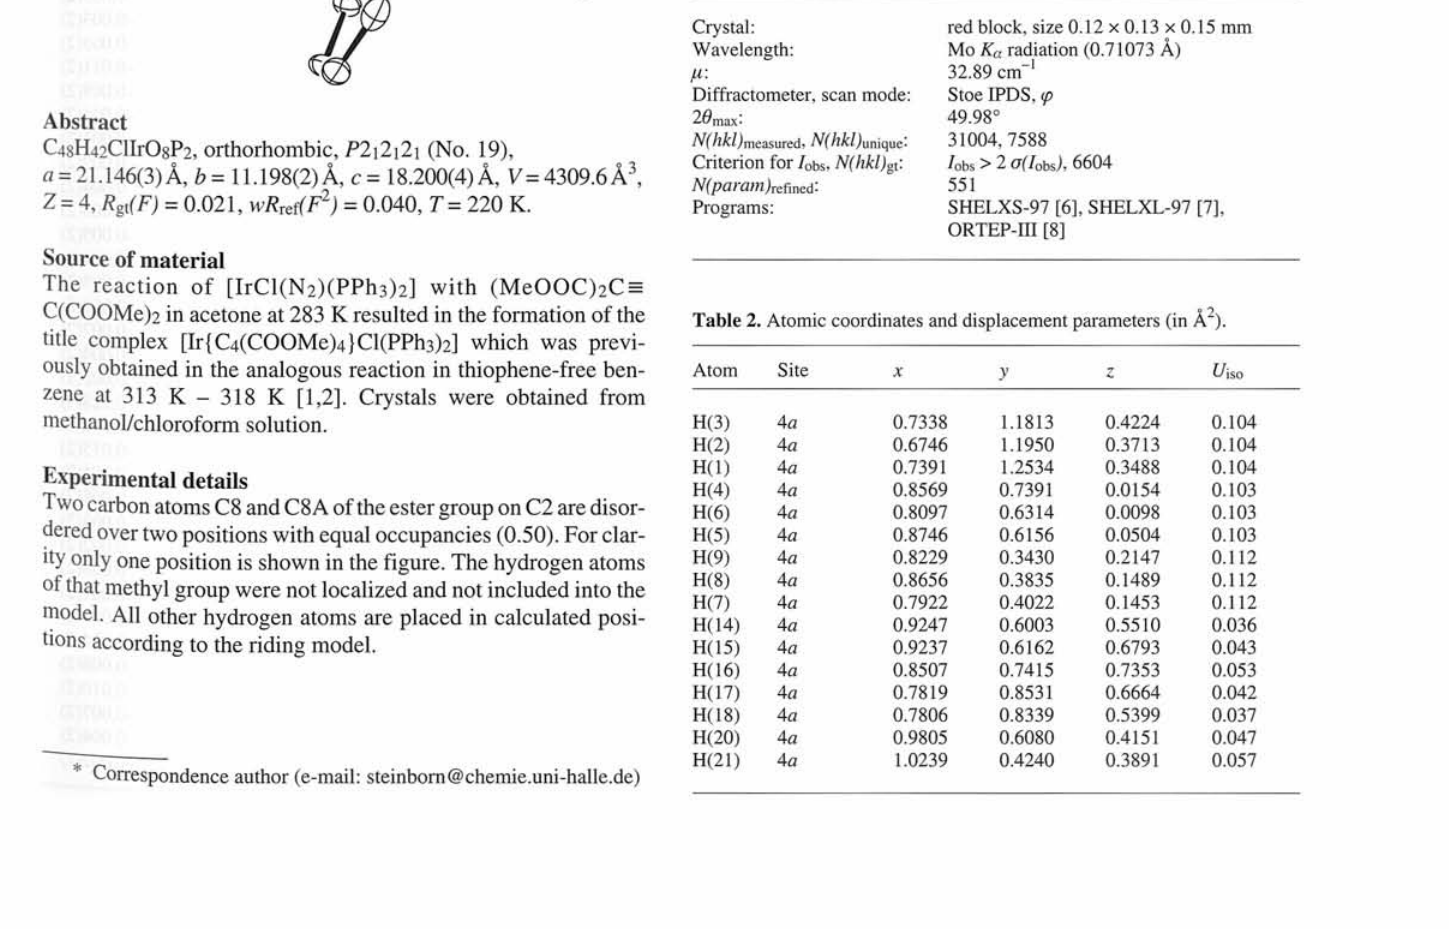
Table 1. Data collection and handling.